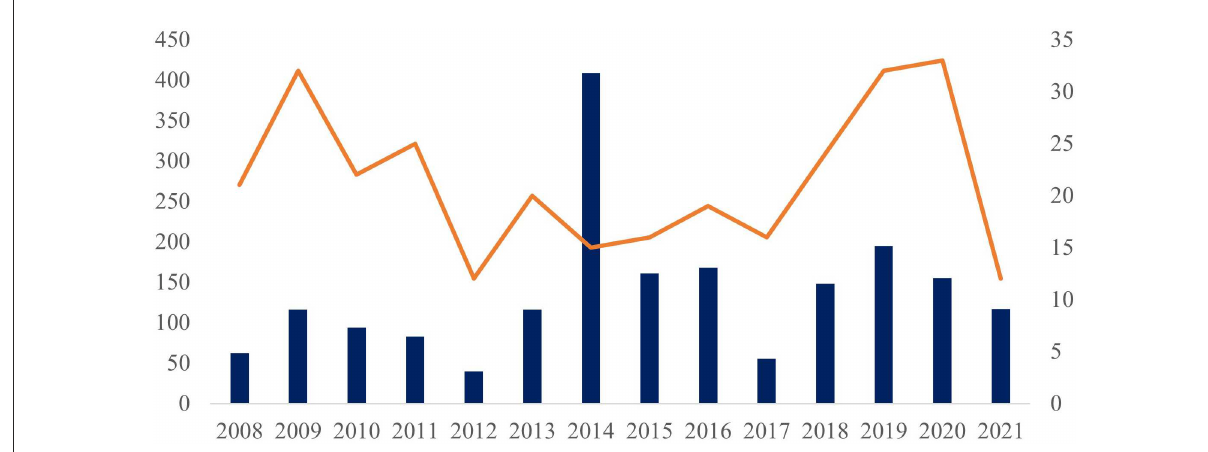
FIGURE1 Number of test protocols (left side and columns) and number of municipalities of origin (right side and orange line) of the samples analyzed in the LRNEM between 2008 and 2021.